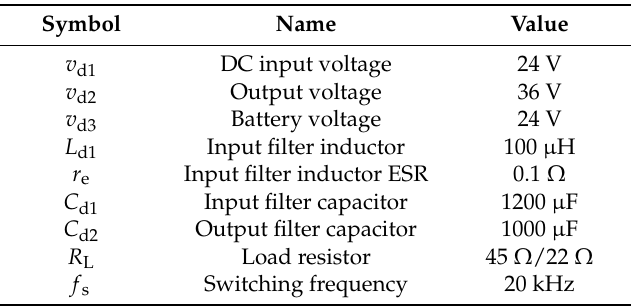
Table 1. Parameters of The Simulation